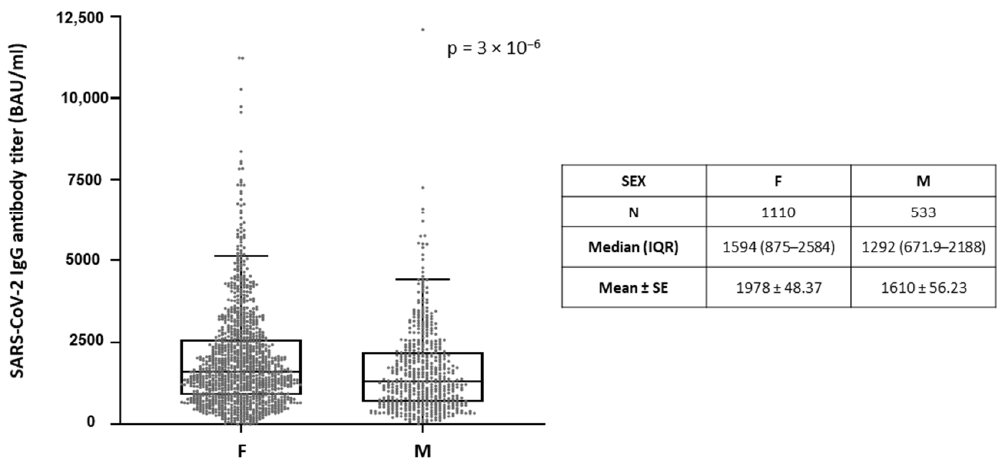
Figure 1. Correlation of anti ‐ SARS ‐ CoV ‐ 2 IgG antibody titers with the age of healthcare workers from the three hospitals Eginition, Evan/smos, and Kon/poulio (total population), after vaccination with the BNT162b2 mRNA vaccine. ( A ) Comparison of antibody titers (BAU/mL) among different age groups by One-Way ANOVA Kruskal-Wallis H test. Data are represented as XY scatter plot and box plots; line in the middle, median; box edges, 25th to 75th centiles; whiskers, range of values. Numeric results are presented in the table below. ( B ) XY scatter plot and fitted linear regression lines of anti-SARS-CoV-2 IgG titers versus age as continuous variable. Spearman’s correlation coefficient (r) and p values ( p ) were calculated.